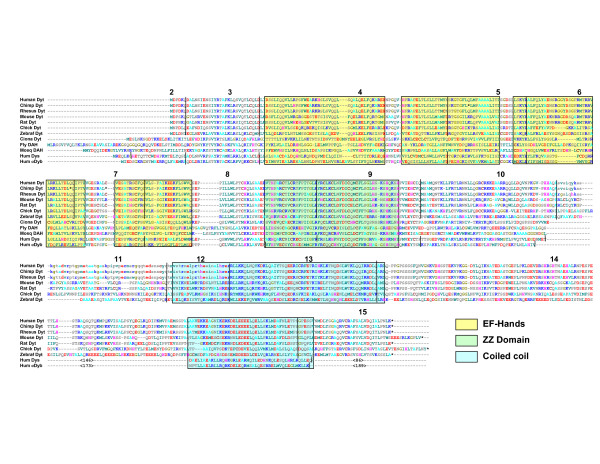
The dystrotelins and DAHs. Alignment of full-length sequences of dystrotelins ("Dyt") from a range of vertebrate species. Those from H. sapiens, M. musculus and D. rerio have been confirmed by RT-PCR and sequence analysis; the remainder are predicted from genomic sequence alone. Also included for context are the N-terminal sections of C. intestinalis dystrotelin-like protein, two insect DAH sequences, human dystrophin (Dp71 isoform; "Dys") and human α-dystrobrevin ("αDyb"; much of the C-terminal regions of these proteins are not alignable with dystrotelins and were omitted). Vertical lines indicate exon boundaries (the invertebrate genes are intronless). Lower case sequences in the primates indicate known (human) or expected (chimp, rhesus monkey) exclusion of the exons from the mRNA. Colour-coded boxes indicate known structural motifs – EF hands [48], ZZ domain [82] and coiled-coil regions predicted by COILS. Note three nonsense mutations (asterisks) in chimp sequence. Accession numbers: H. sapiens dystrotelin, [GenBank:DQ516347]; M. musculus dystrotelin, [GenBank:DQ443727]; D. rerio dystrotelin, [GenBank:DQ443726]; C. intestinalis dystrotelin, [GenBank:BR000175]; D. melanogaster DAH, [GenBank:AAC24159]; H. sapiens Dp71, [GenBank:M92650], H. sapiens α-dystrobrevin, [GenBank:NM_001390].